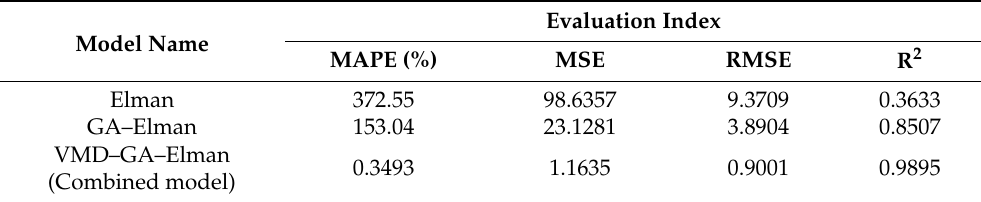
Table 7. Comparison of the prediction accuracy of different prediction models.